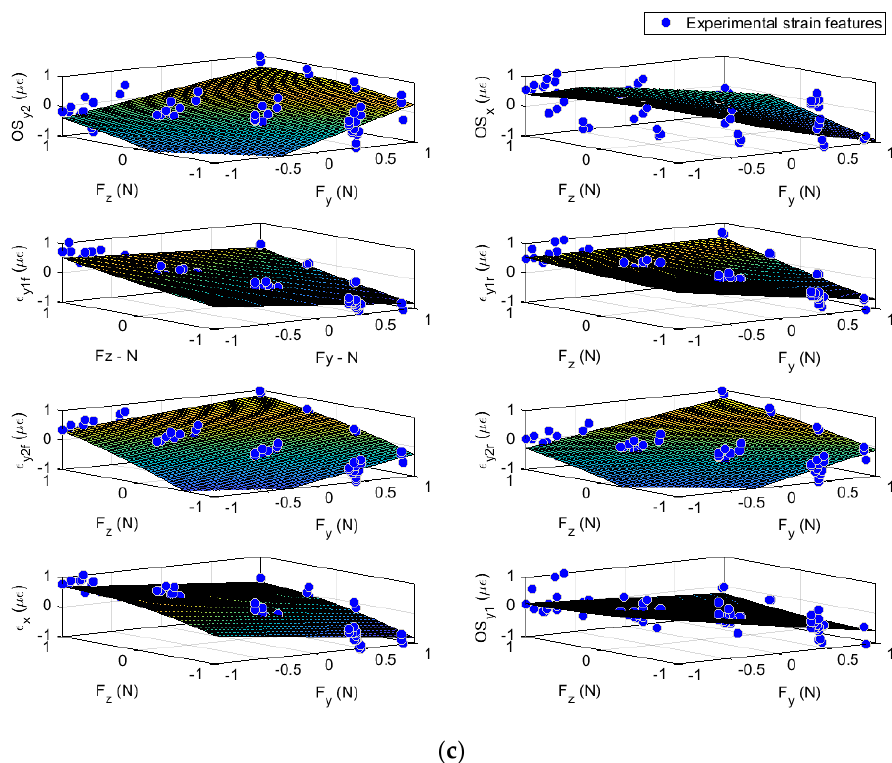
Figure A1. Curve surface fitting, variation of the strains features as function of potential parameters. ( a ) Strain features as function of vertical load and longitudinal force. ( b ) Strain features as function of slip angle and lateral force. ( c ) Strain features as function of vertical load and lateral force.